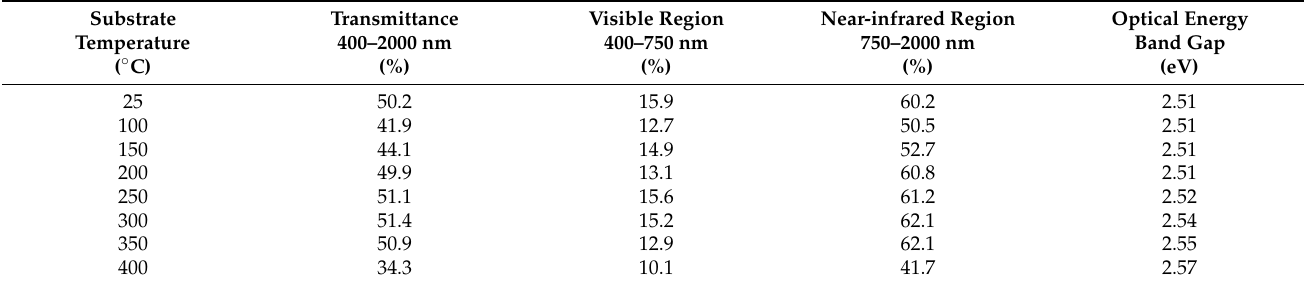
Table 3. Average transmittance and optical energy band gap values of Cu 2 O thin films deposited at various substrate temperatures.